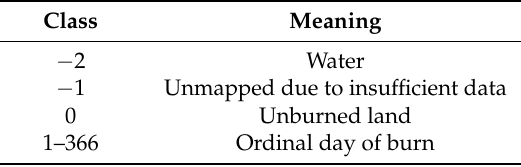
Table 1. MOD14/MYD14 fire mask pixel